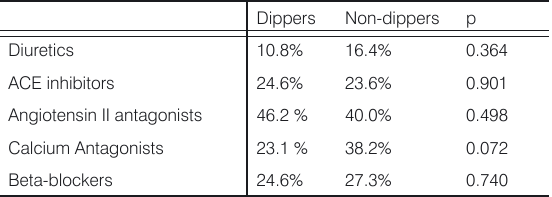
Table 3. Anti-hypertensive medications of study